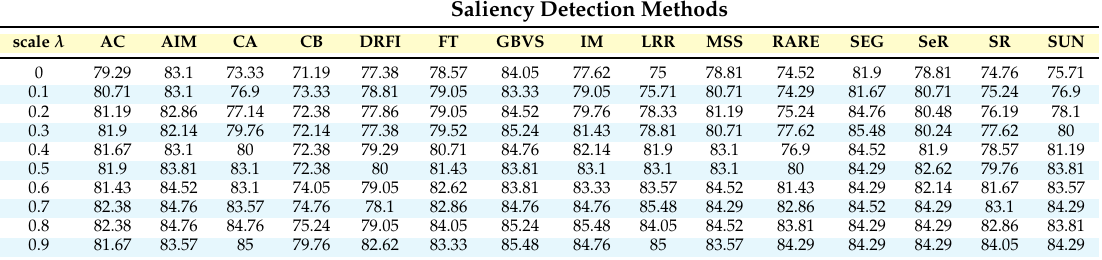
Table 4. Comparison of the classification performance of saliency-based coding via different saliency detection methods. AIM, attention by information maximization; CA,